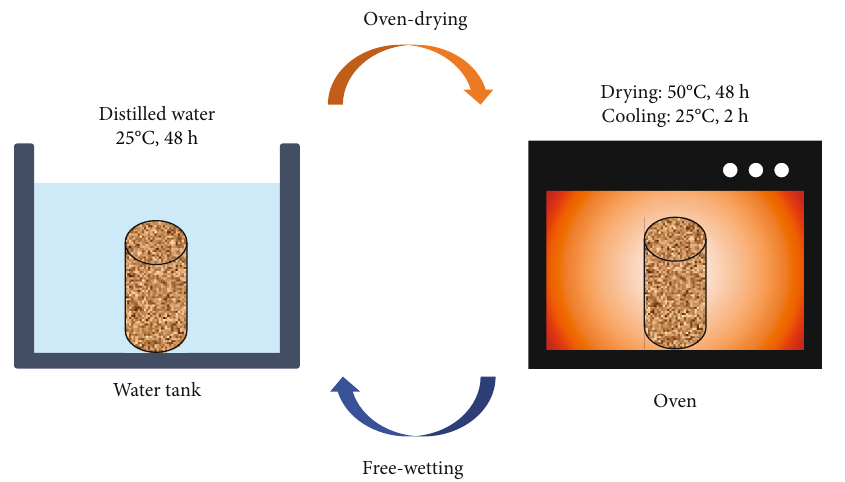
Figure 2: Schematic of a whole wetting-drying treatment process.